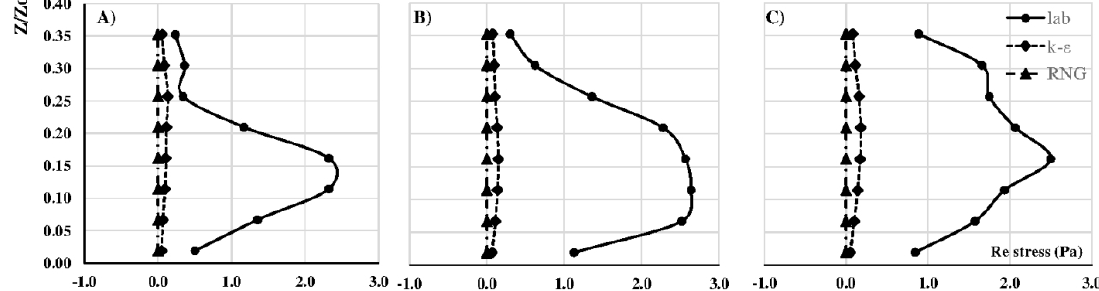
Figure 15. Comparison of measured and computed vertical turbulent shear stress profiles in the experimental zone for ( A ) 2.45 m; ( B ) 2.50 m and ( C ) 2.55 m distance from